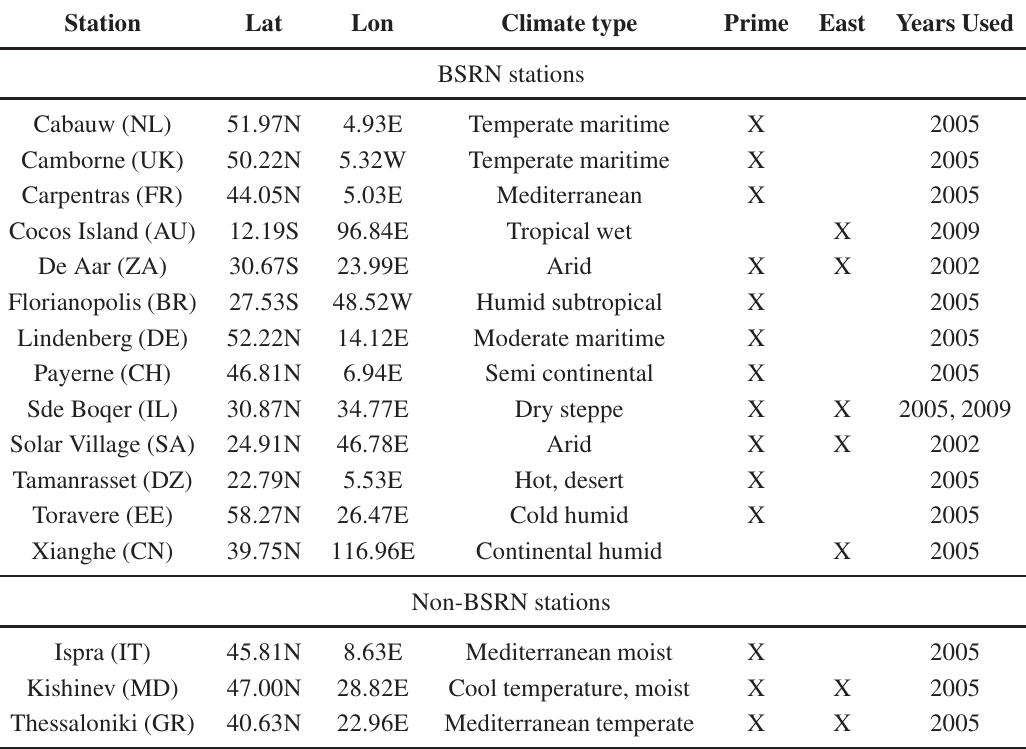
Table 2. List of radiation measurement stations used in the validation of the satellite-based radiation estimates. The “Prime” and “East” columns indicate whether they were used to validate data from the Prime and East satellite positions, respectively. Kishinev and Thessaloniki have only hourly average data available, for the other stations the 1-min data have been averaged over a 10-min